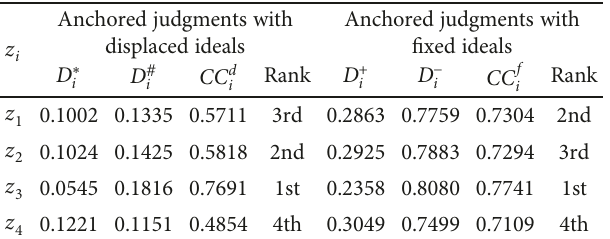
Anchored judgments with fi xed ideals